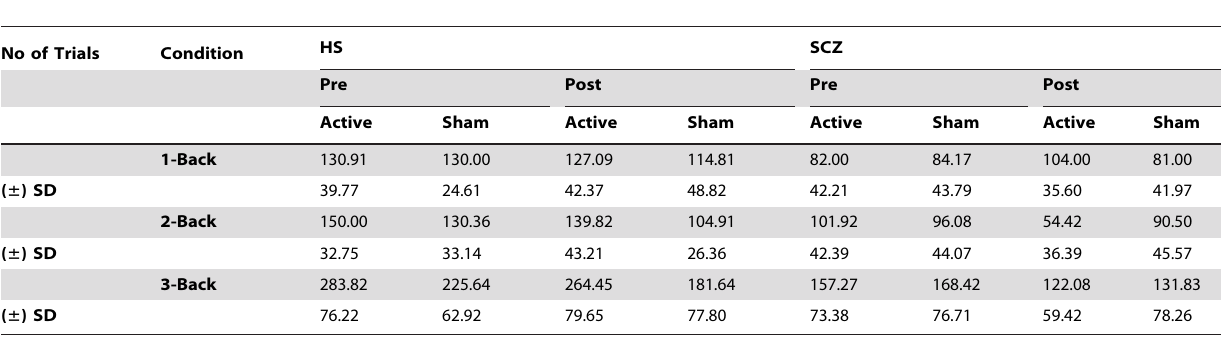
Table 2. Total number (TC + NTC) of trials analyzed for healthy subjects (HS) and patients with schizophrenia (SCZ) in the 1-, 2-, and 3-back task conditions pre- post-rTMS ( 6 ) 1 standard